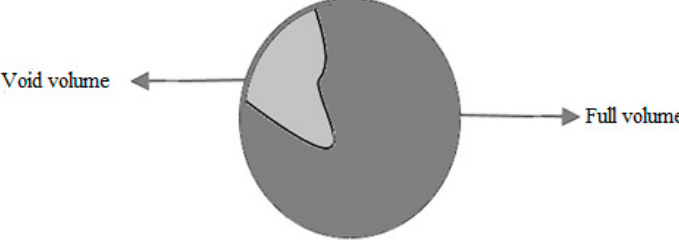
Figure 2. Schematic representation of the porous biofuel particle considered in the current analysis.